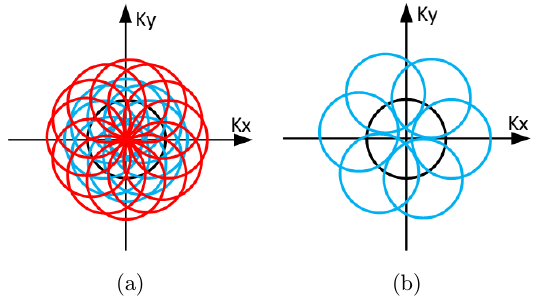
Fig. 4. Two di®erent overlapping cases of spectrum in fre- quency domain. The overlapping area between the two adja- cent circular spectra is about (a) 75%, and (b) 25%.